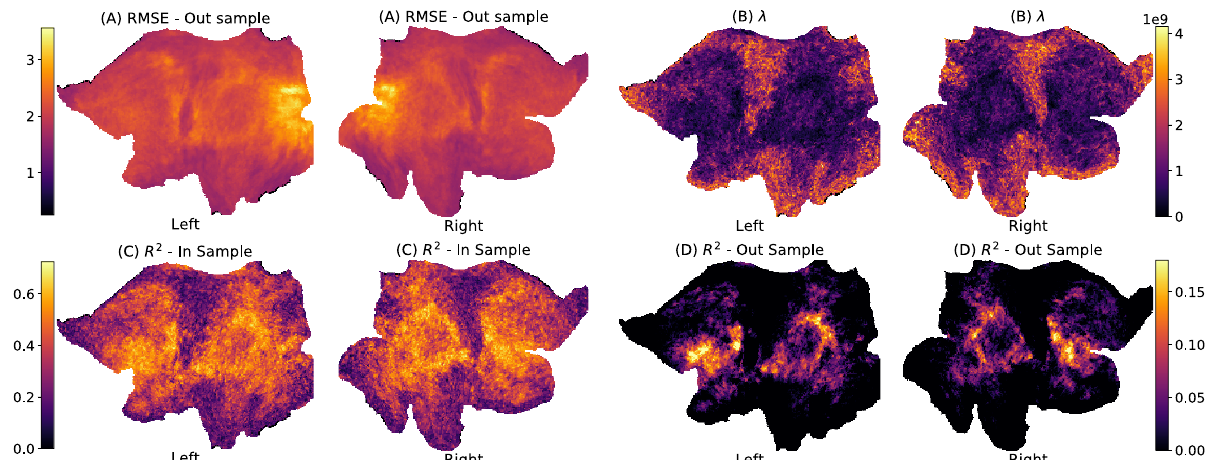
Figure 6. Flatmap cortical surface projections of MMP-RR-PCR model fits. ( A ) root mean square error (RMSE), ( B ) Degree of regularization (cid:31) in model fit, ( C ) R 2 RMSE, (cid:31) , and R are averaged across all 47 model fit results. Train and test R each other. (cid:31) shows how regularization is inversely related to the method’s ability to predict ( R 2 wise R and regularization parameter (cid:31) offer the ability to resolve spatially where rsfMRI data is capable of any